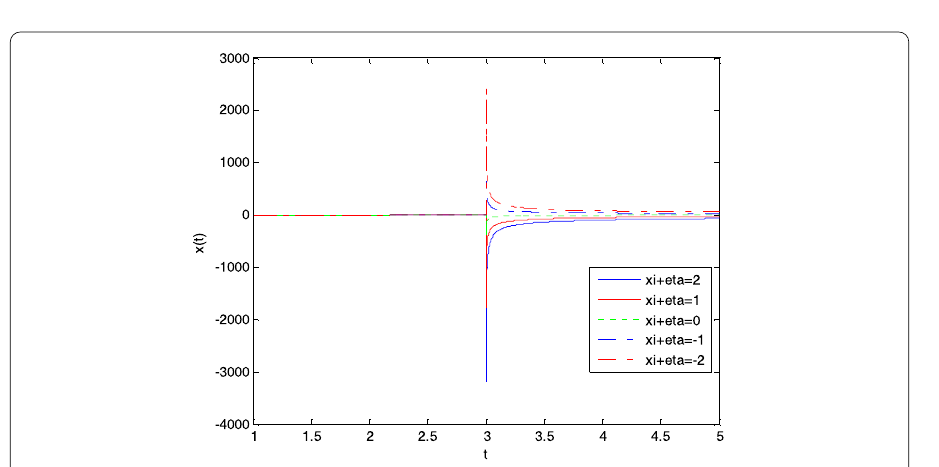
Figure 10 The solution trajectory of system (5.3) with ρ = 0.5